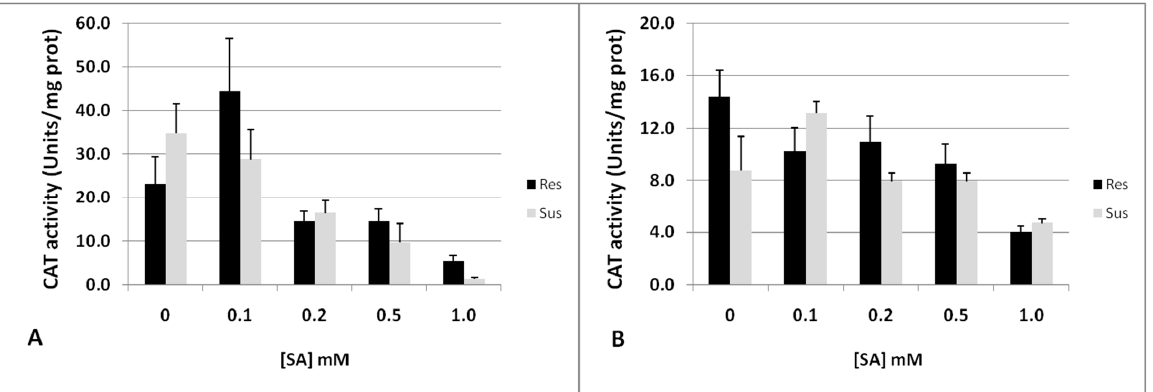
Figure 6. High- ( A ) and low- ( B ) molecular-weight isoCATs (hmwtCAT and lmwtCAT, respectively) activity of AS-precipitates from root soluble fractions of tomato plants resistant (Motelle, Res) and susceptible (Moneymaker, Sus) to RKNs. CAT was assayed in absence and presence of increasing concentration of K-salicylate (0.1–1.0 mM, pH 6.0). Values are expressed as means ( n =3) ± SD.